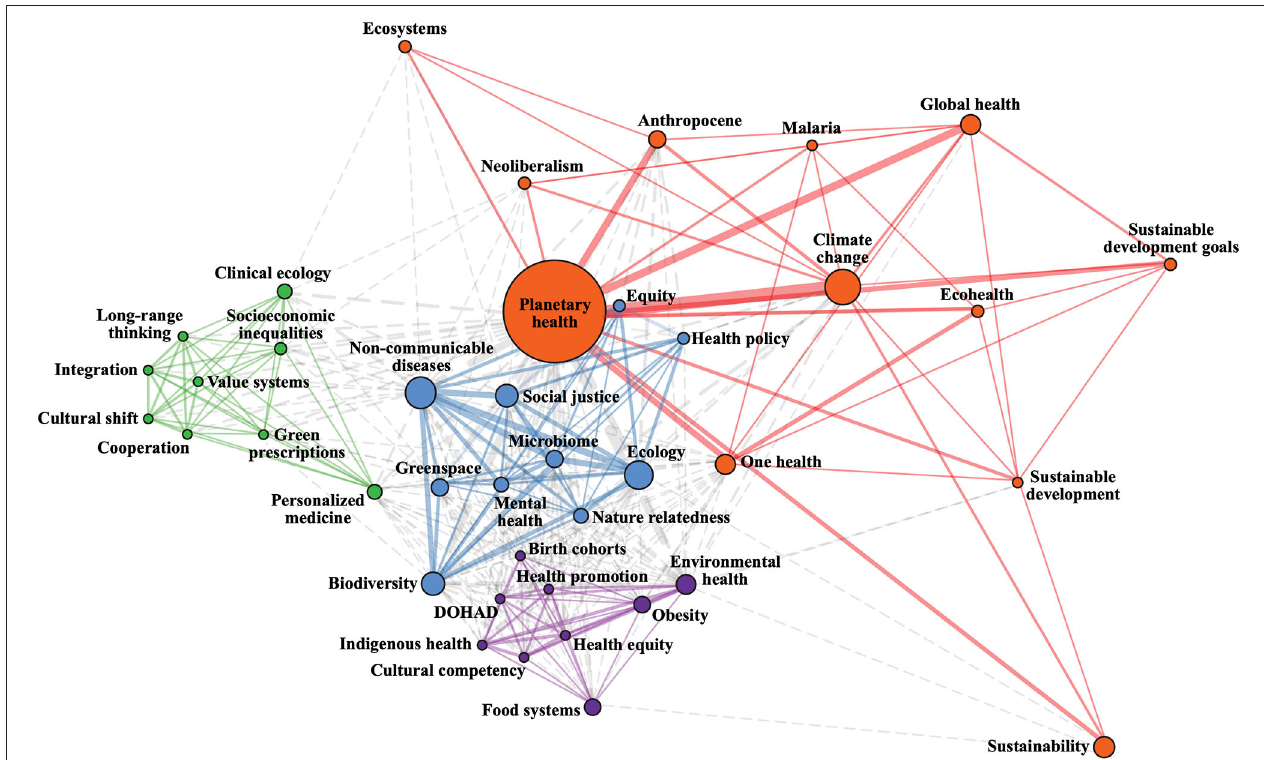
FIGURE 4 | Network plot representing keyword clusters. Colored lines represent connections between keywords within the same cluster while dotted lines represent connections between keywords in different clusters. Increasing line thickness and node size represent higher numbers of connections between clusters and higher usage of a keyword,